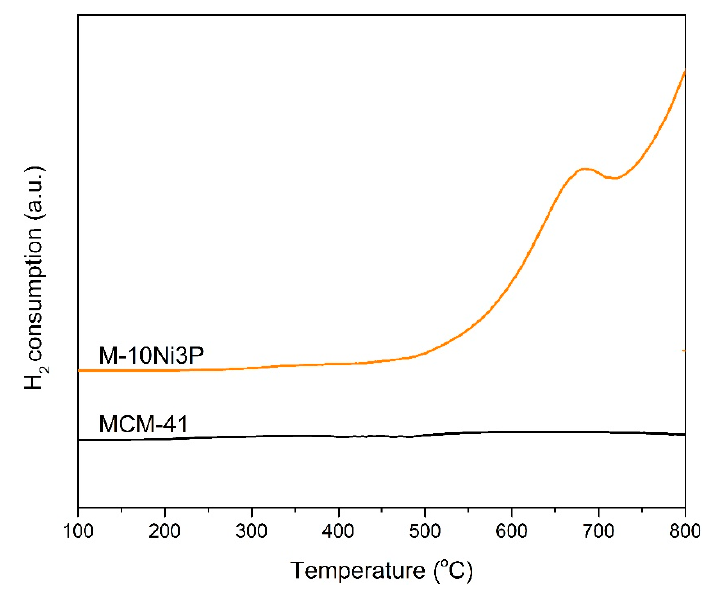
Figure 6. H 2 -TPR profiles of MCM-41 and calcined M-10Ni3P precursor.